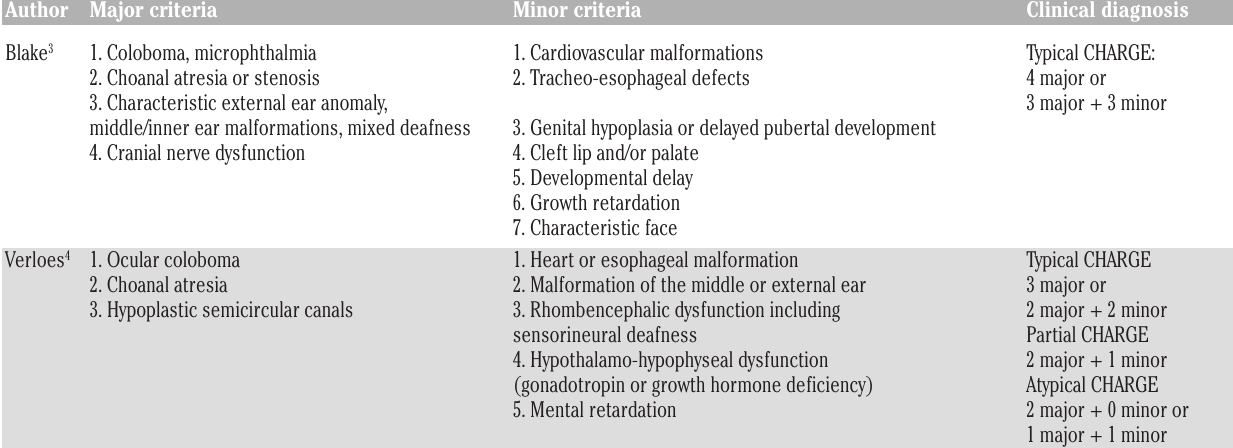
Table 1. Comparison of clinical criteria for CHARGE